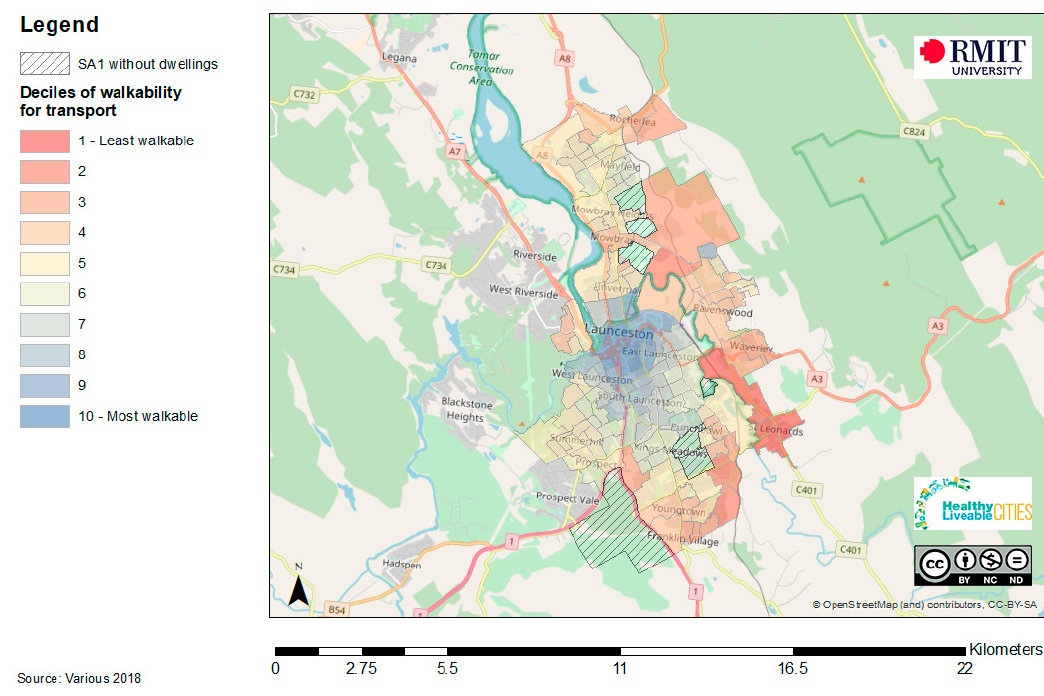
Figure 2. An example of a walkability assessment for the city of Launceston, Tasmania, Australia [52].